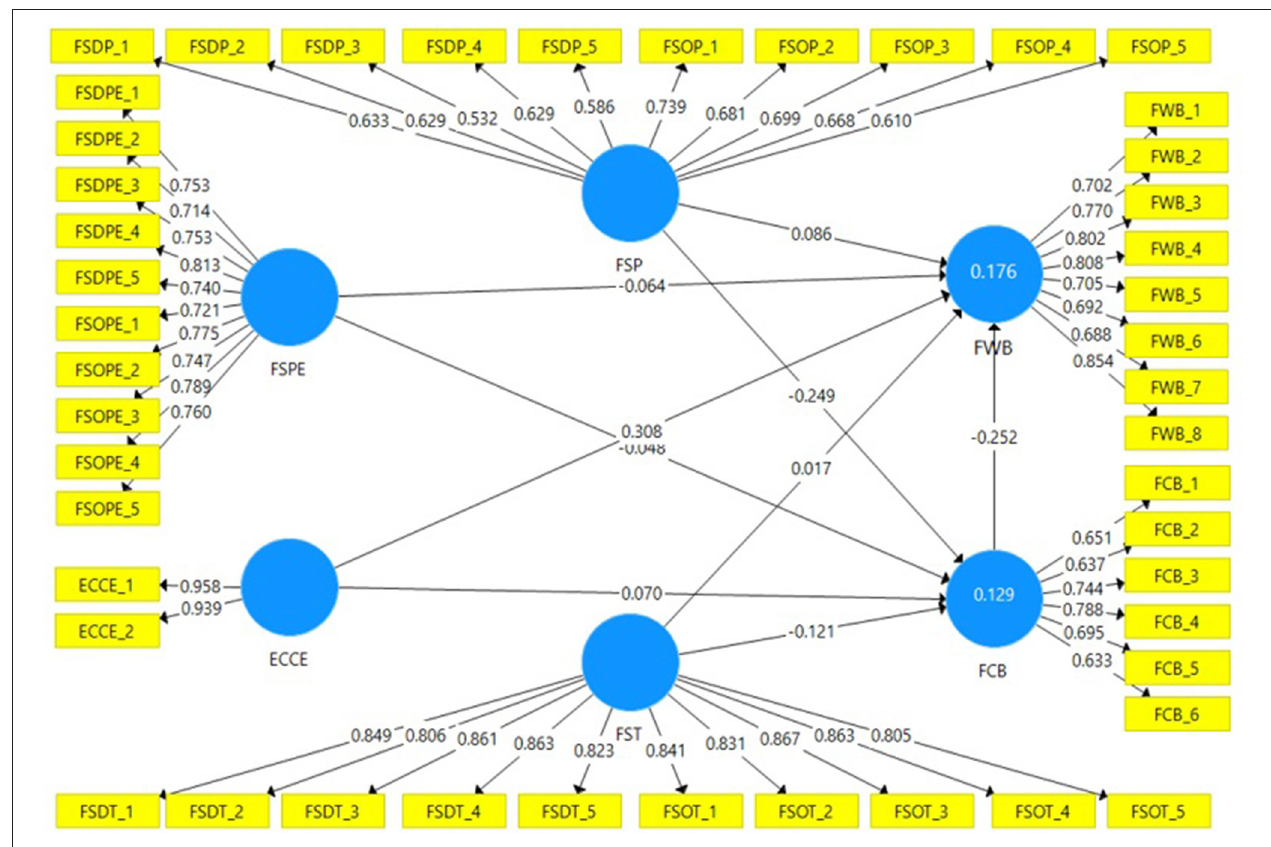
FIGURE 2 | Direct, indirect, and total effect of the relationships. Source: Researcher.